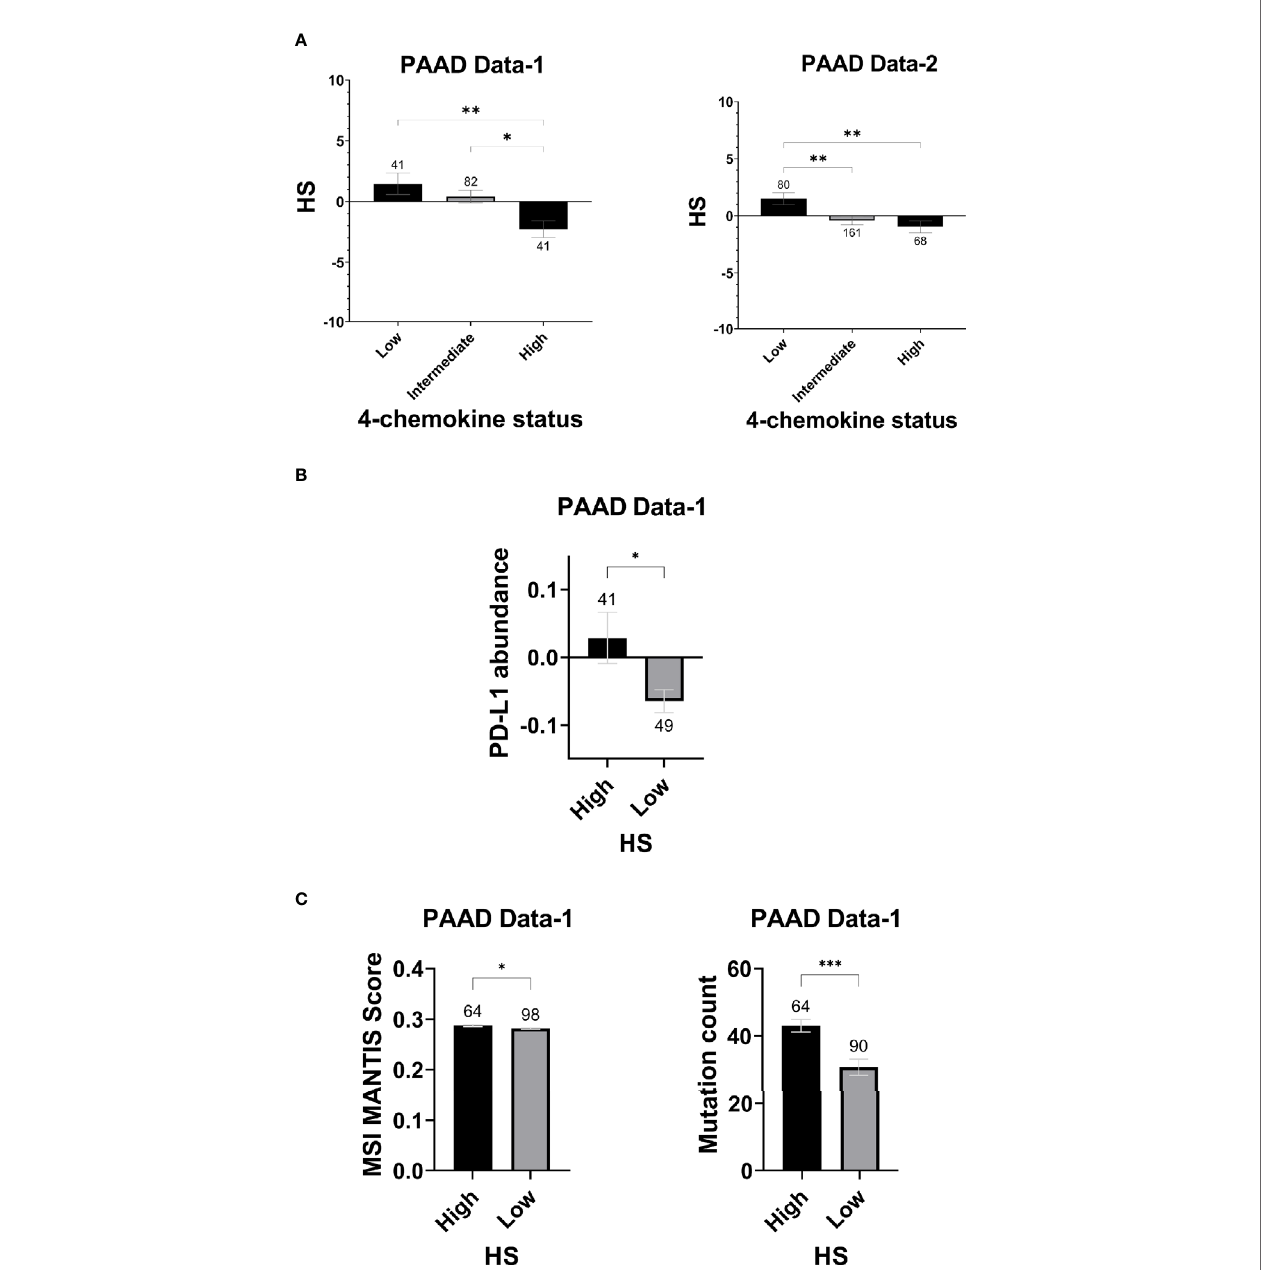
FIGURE 6 | Hypoxia score and indicators of ICI in pancreatic cancer: (A) Mean SEM of hypoxia scores in tumors classi fi ed according to the four-chemokine signature. (B) Mean SEM of PDL-1 protein abundance levels based on RPPA in HS high and low tumors. (C) Mean SEM of MSI and Mutation count in HS high and low tumors. MSI scores are based on the MSI-calling tool, MANTIS. Signi fi cance determined by ordinary one-way ANOVA with Bonferroni correction for multiple testing (A) and two-tailed unpaired t-test analysis (B, C) . P-value < 0.05 considered statistically signi fi cant. Number of samples in each group is indicated above the error bars. *p-value > 0.01; **p-value < 0.0021; ***p-value < 0.0002; ****p-value <